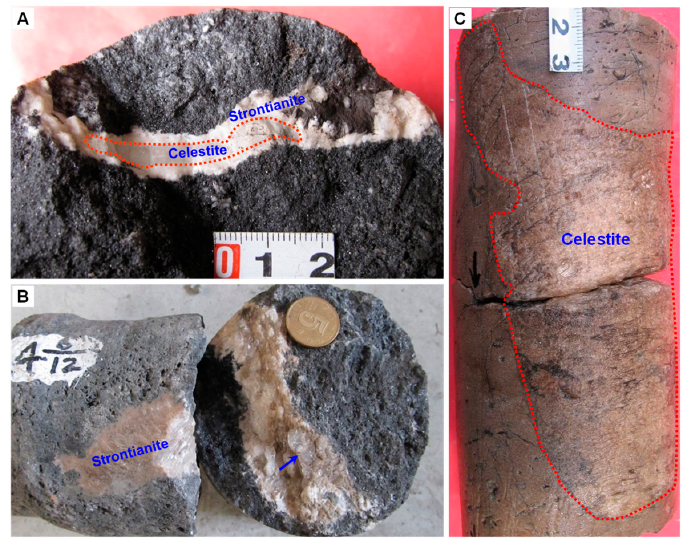
Figure 3. Photographs of drilling cores showing the occurrence of celestites and strontianites in the YB gas field. ( A ) Celestite and strontianite minerals in the fracture of dolostone, 6640.15m, P 3 c , YB29. ( B ) Celestite particles (blue arrow) and strontianite in the dissolution fracture of dolostone, 6461.73m, P 3 c , YB205. ( C ) Celestite mineral completely filled in the dissolution vugs of dolostone, 6583.10m, P 3 c , YB2.